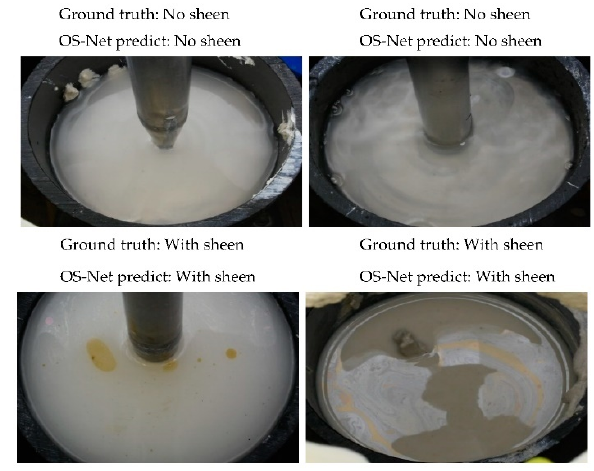
Figure 5. Example oil sheen image ground truth and OS-Net prediction results.